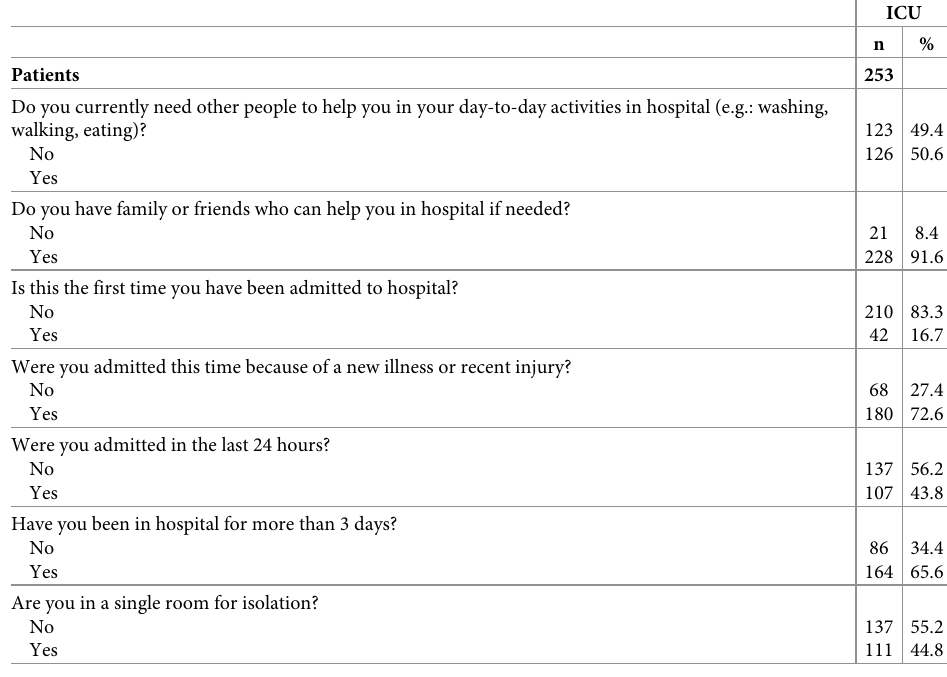
Table 2. Other patient and admission characteristics according to whether admitted to ICU (questions 29–35).